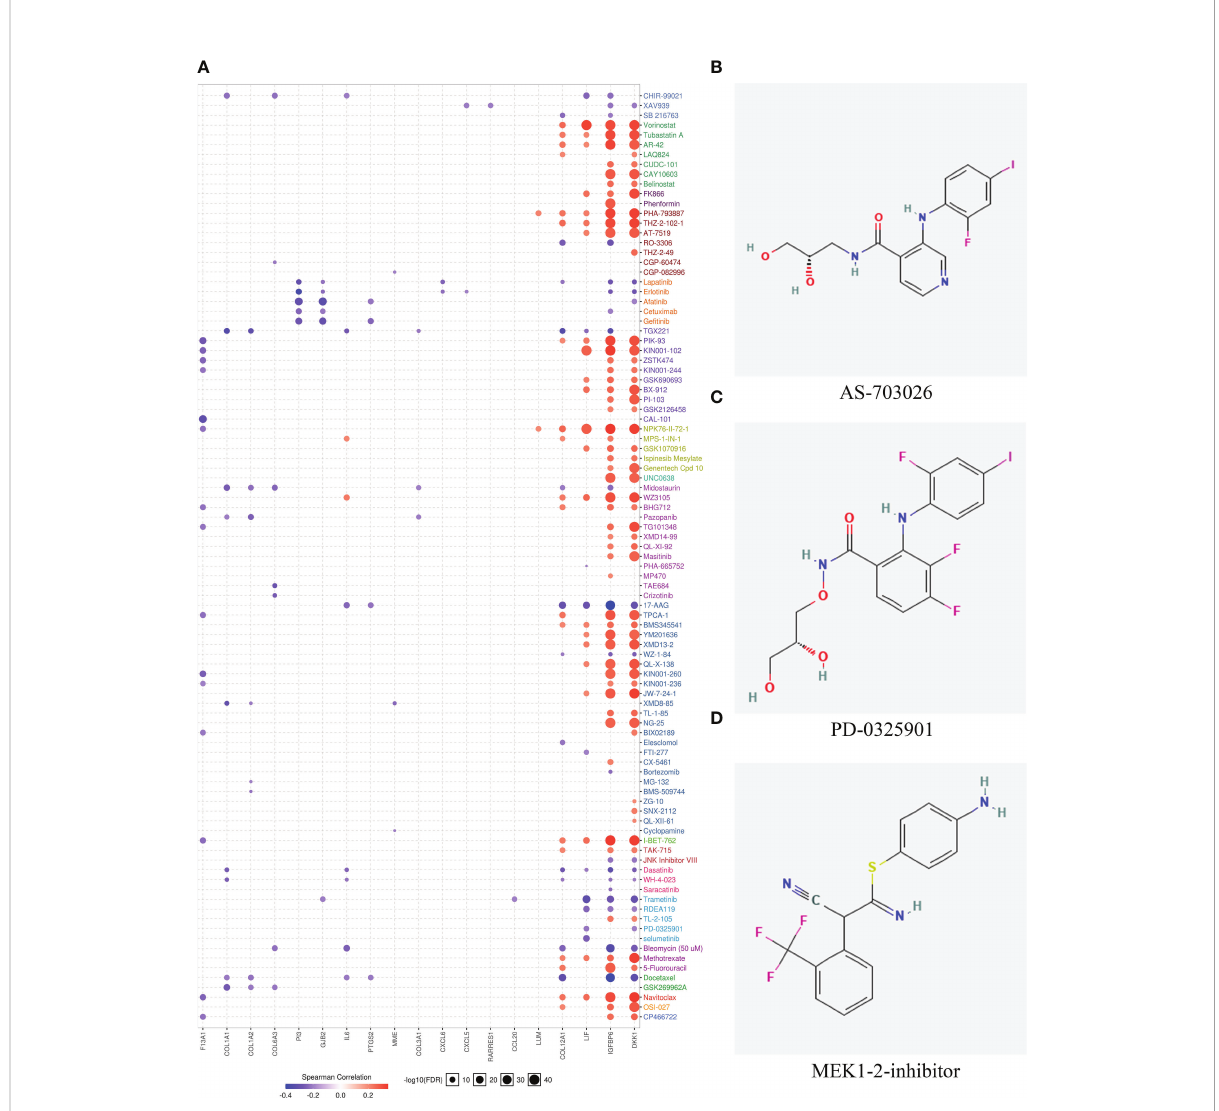
FIGURE 6 Drug sensitivity evaluation based on hub genes and potential drug prediction for patients within the MES subtype. (A) The bubble plot showed the correlation between the mRNA expression of genes that were upregulated in the mesenchymal subtype and GDSC drug sensitives. (B – D) Structures of the three most signi fi cant bioactive chemicals sharing common MOA of MEK inhibitor by CMap